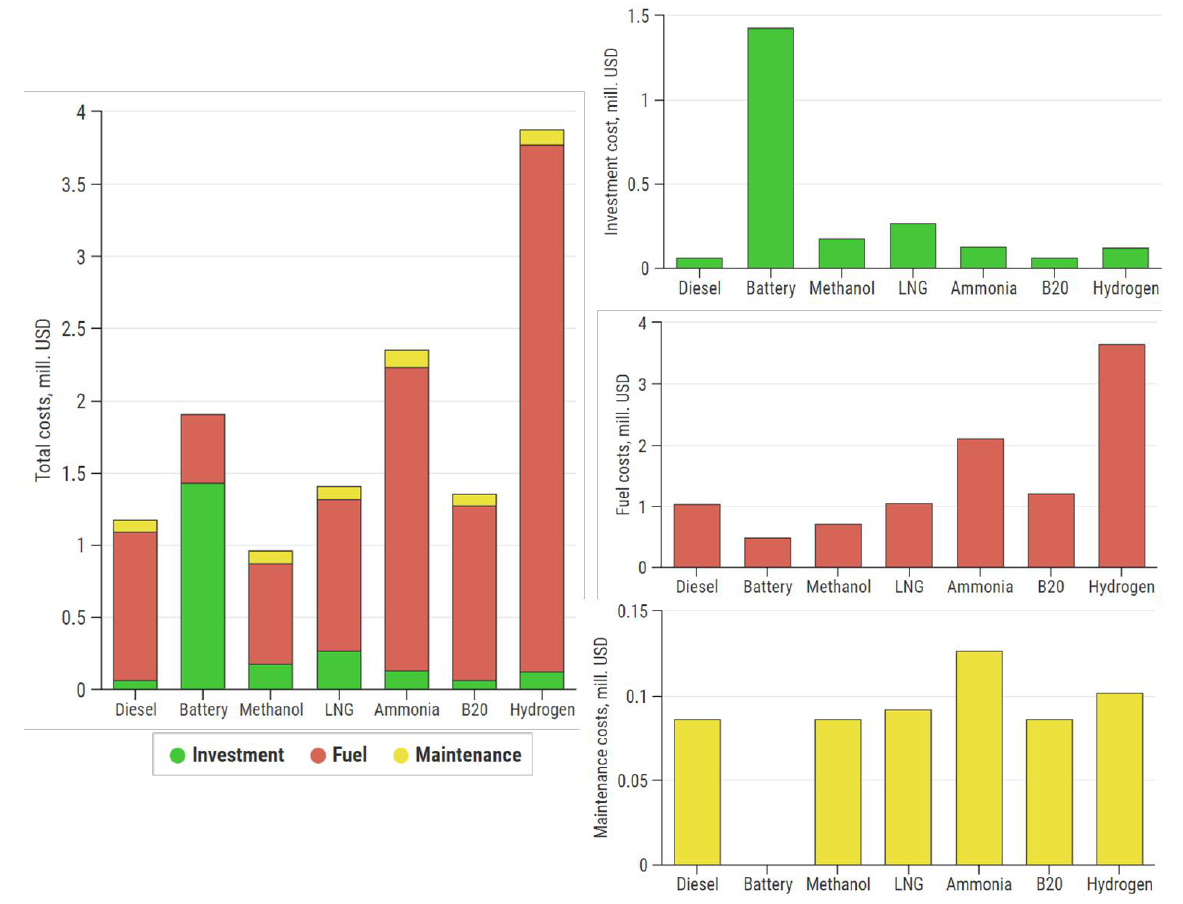
Figure 14. LCCA results for a trawler “Jadran